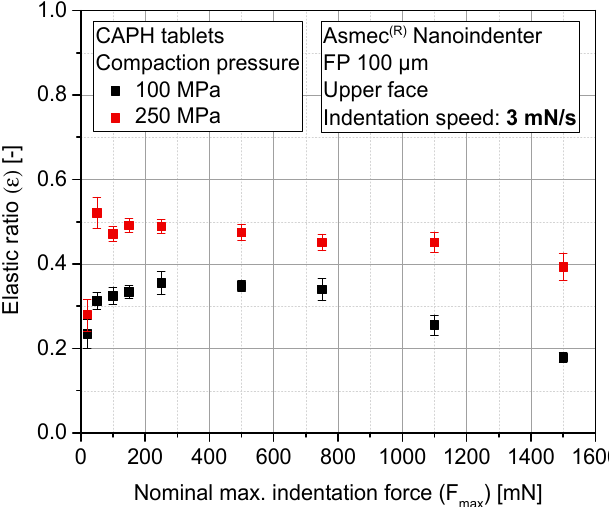
Figure 11. Elastic ratio ( ε ) of CAPH tablets as a function of the maximum indentation force for different nominal compaction pressures.